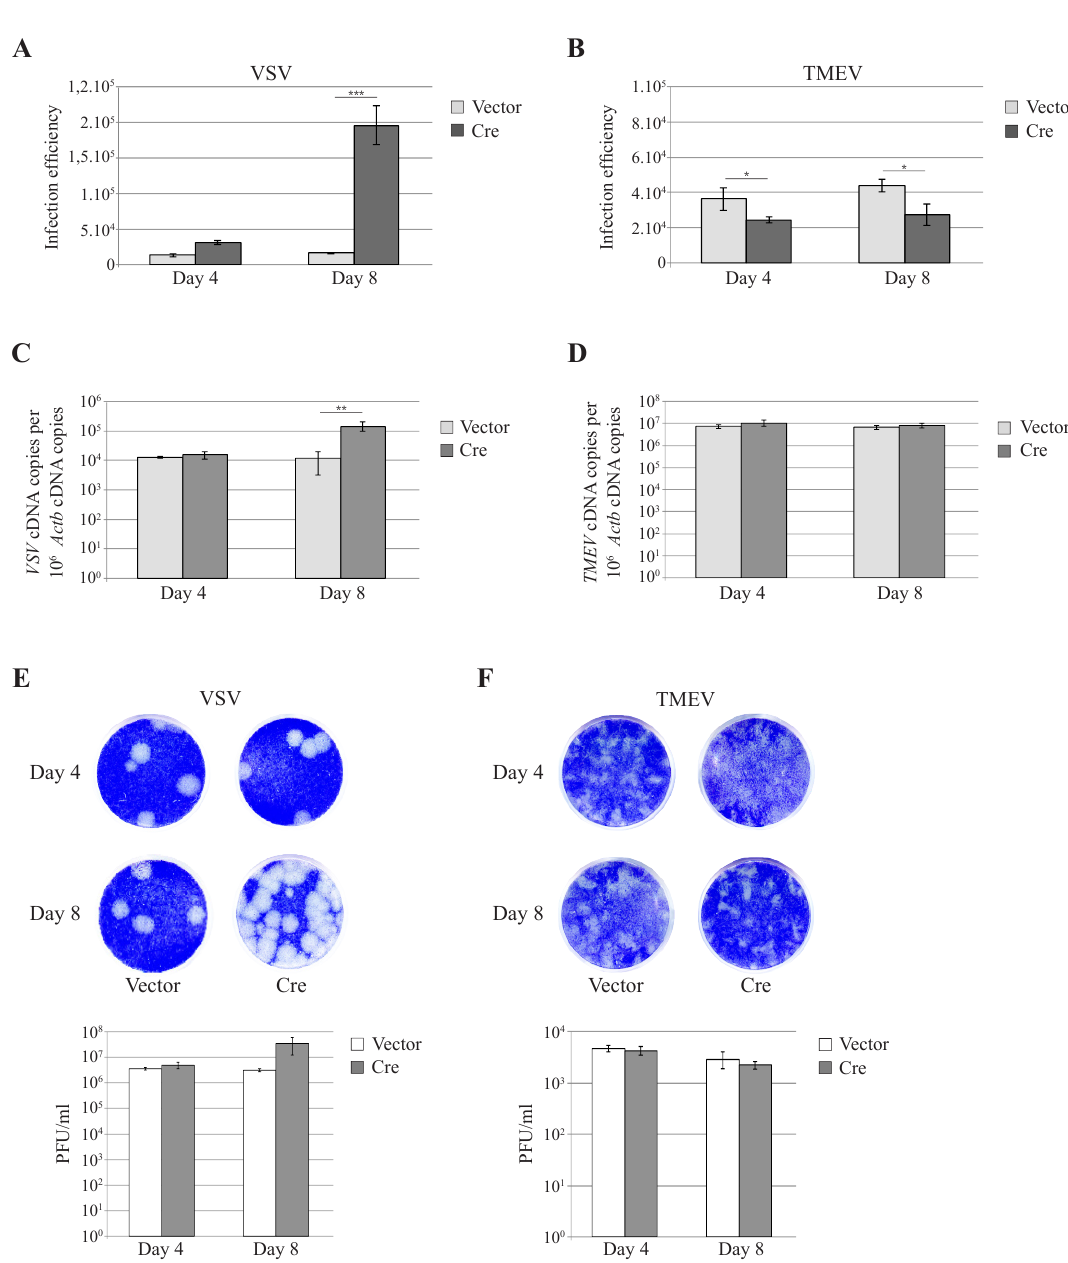
Figure 4. Impact of Dicer inactivation on VSV and TMEV infection. Infection by GFP expressing derivatives of VSV and TMEV was compared in Dicer flox/null MEFs that were transduced for 4 or 8 days with TM945 expressing mCherry alone (Vector) or with ADC82 co-expressing mCherry and Cre (Cre). Cells were then infected in triplicate with 10 PFU per cell of VSV during 7 h or with 1 PFU per cell of TMEV during 8 h. Graphs show the mean and SD of VSV and TMEV infection efficiency as determined by flow cytometry ( A , B ) (1 representative experiment out of 2); RT-qPCR ( C , D ) or plaque assay (magnification: 0.33 ˆ ) ( E , F ). * p < 0.05, ** p < 0.01, *** p <